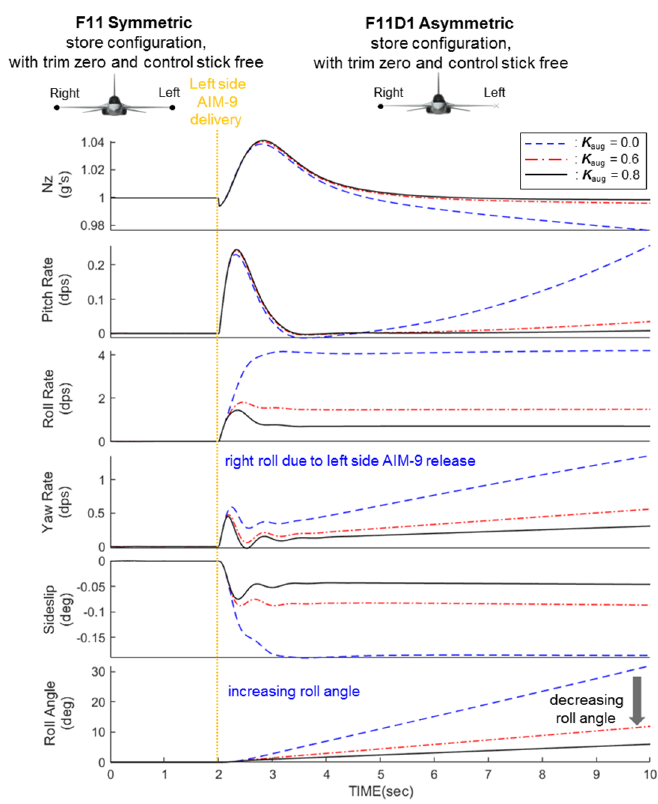
Figure 11. Transient response to asymmetric weapon delivery in M0.8, 20 Kft altitude.